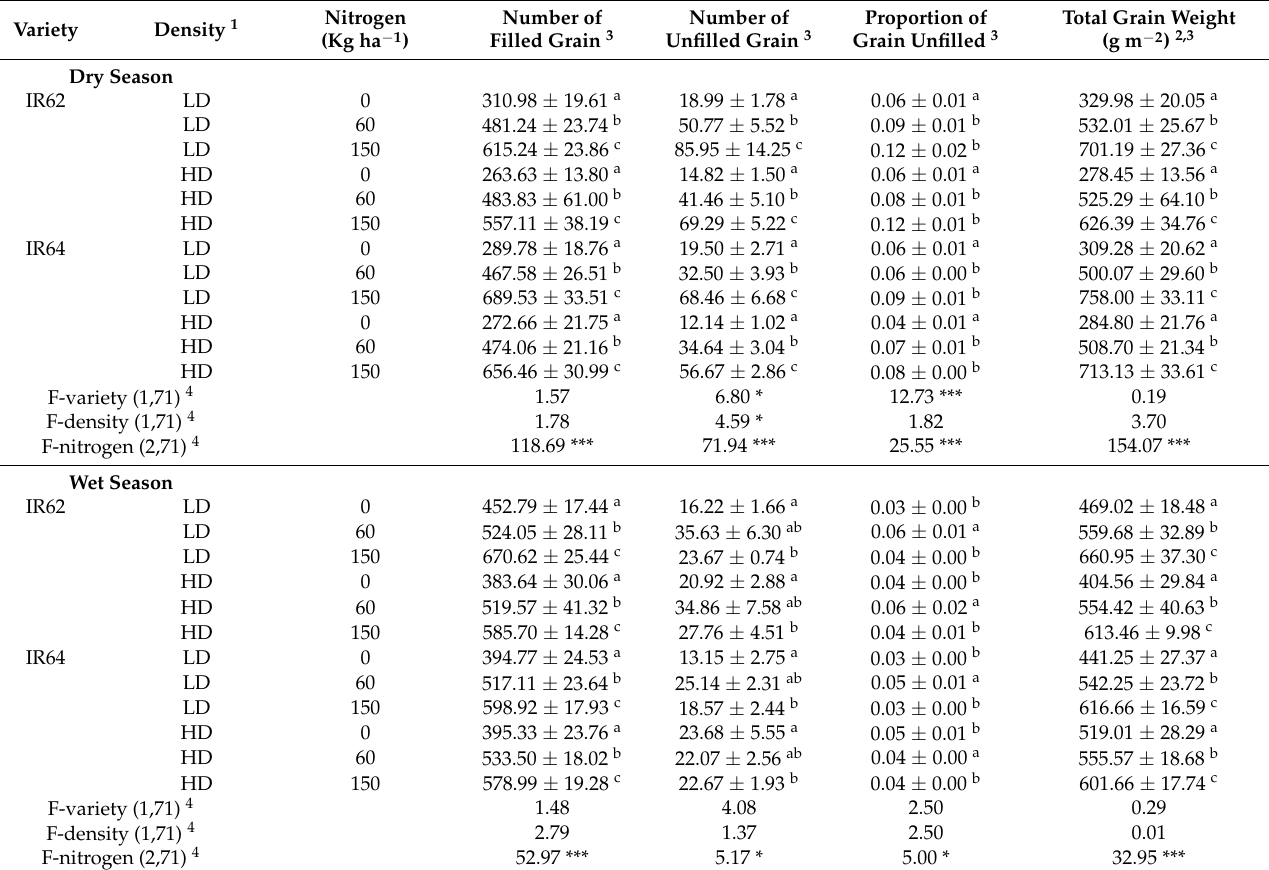
Table 2. Grain yields per m 2 quadrat at harvest. Numbers are means ± SEM ( N =